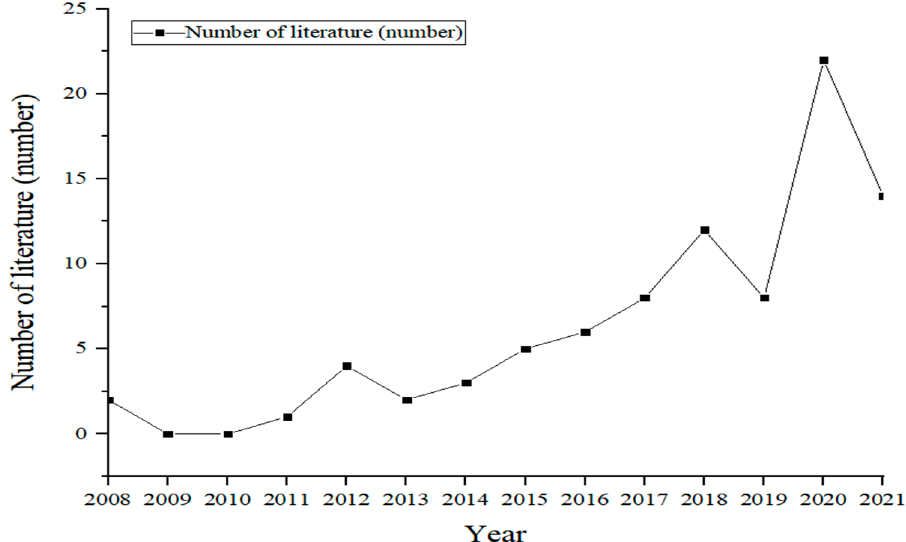
Figure 1. Annual distribution of research documents about vulnerability and resilience of the village ecosystem.